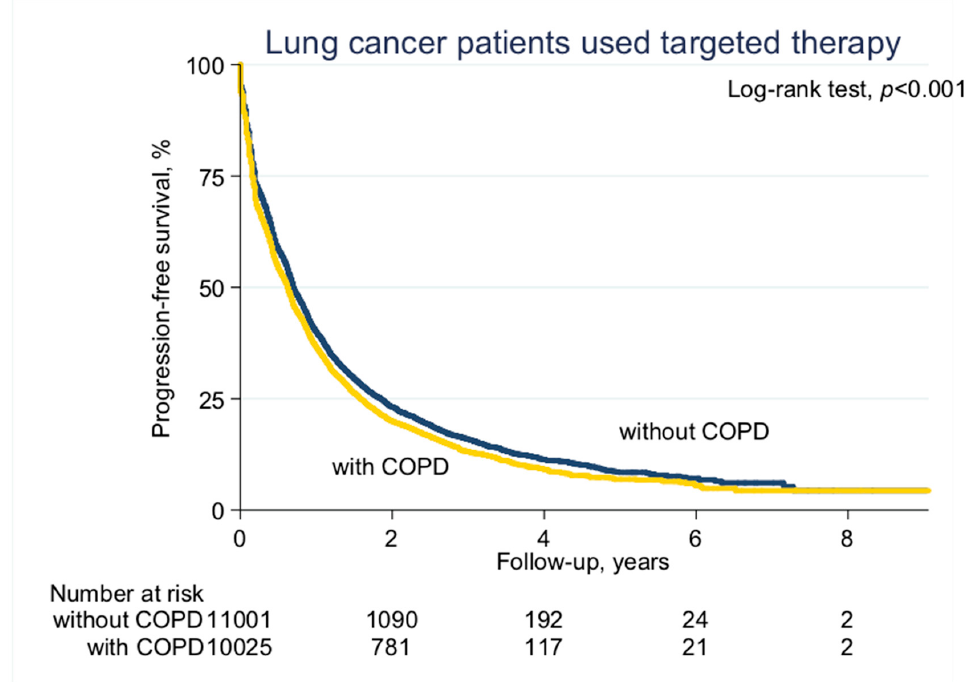
Figure 2. Progression-free survival curve of chronic obstructive pulmonary disease (COPD) and non-COPD cohorts (before propensity score (PS) matching).